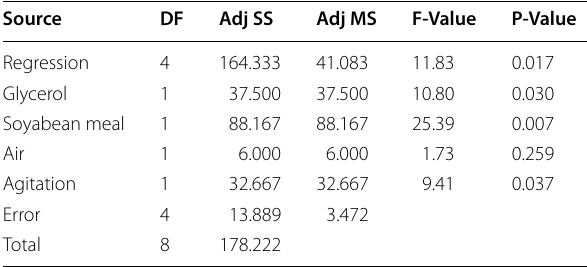
Table 7 Analysis of Variance for Biomass (DCW) production by Streptomyces sp. RA-WS2